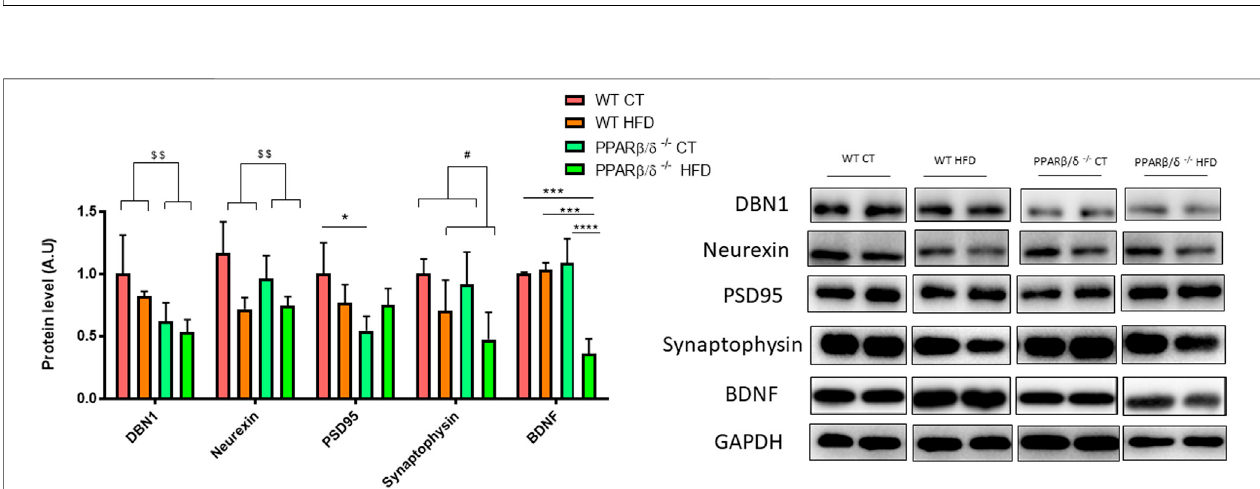
FIGURE4| Immunoblotdetectionofsynapticproteinswheretworepresentativesamplesoutoffourpergroupareshown.AllresultsarepresentedasMEAN±SD. Datawereanalyzedbytwo-wayANOVA( n ≥ 4)(DBN1andneurexin:WTvs.PPAR β / δ -/- : $$ denotes p < 0.01)(synaptophysin:CTvs.HFD: # denote p < 0.05).Inthecase of PSD95and BDNF, Tukey post-test wasperformed (PSD95: WT CT vs. PPAR β / δ -/- CT: *denotes p < 0.05) (BDNF:WT CTvs . PPAR β / δ -/- HFD:***denote p < 0.001; WT HFD vs . PPAR β / δ -/- HFD: *** denote p < 0.001; PPAR β / δ -/- CT vs . PPAR β / δ -/- HFD: **** denotes p < 0.0001.